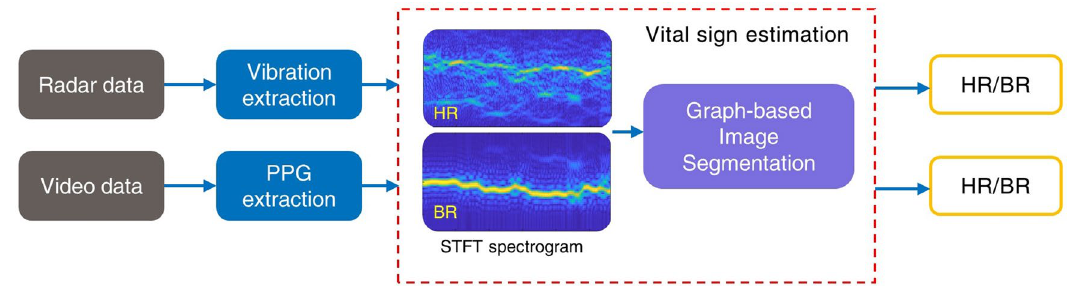
Figure 5. The system operation flow chart for vital signs estimation using data from FMCW radar and face video